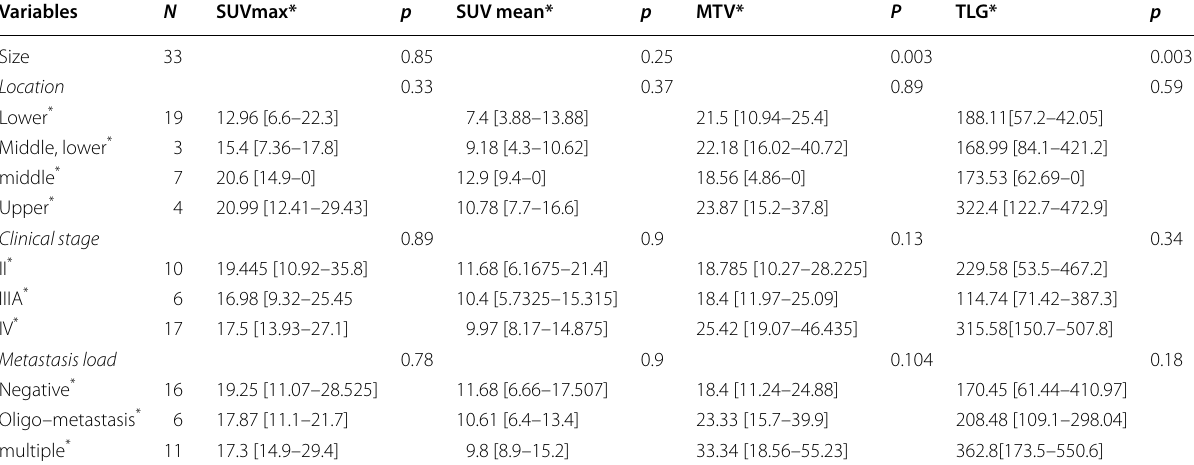
Table 3 Correlations between metabolic parameters of FDG-PET/CT and patient/tumor characteristics